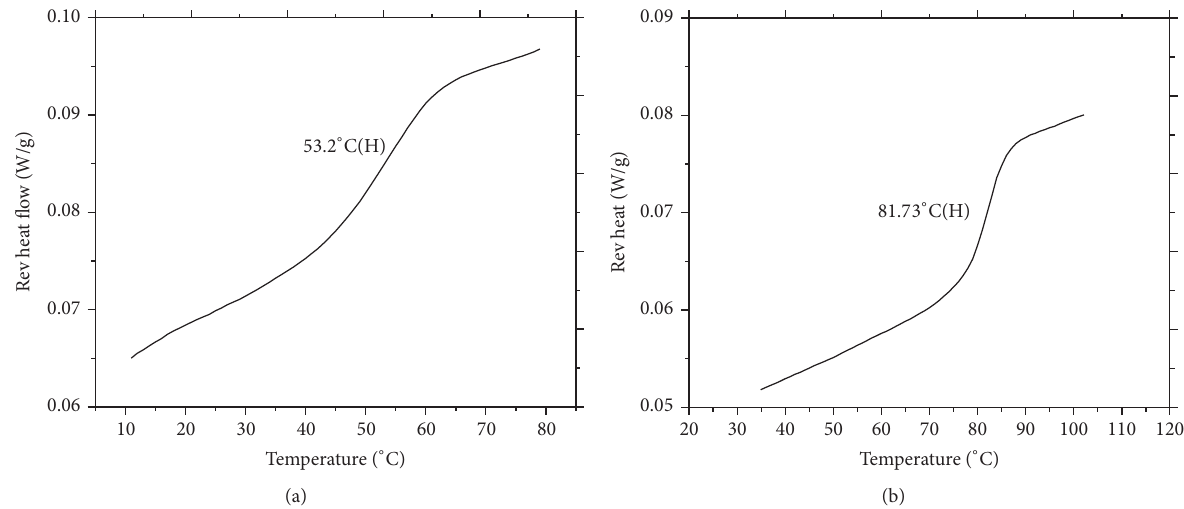
Figure2:ThermogramsbyDSCofmicrospheresof(a)Rx-29containingpoly(ethylhexylacrylate)(10%molarratio)and(b)Rx-33containing poly(butyl acrylate) (17%).